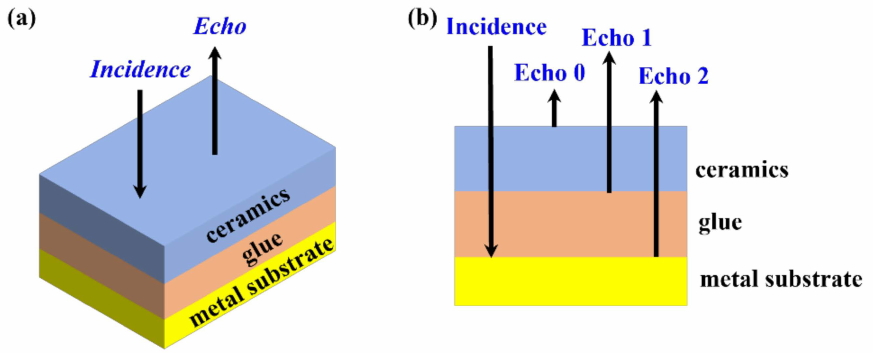
Figure 1. The model of the three-layered structure in this work: ( a ) 3D view; ( b ) the cross-sectional schematic